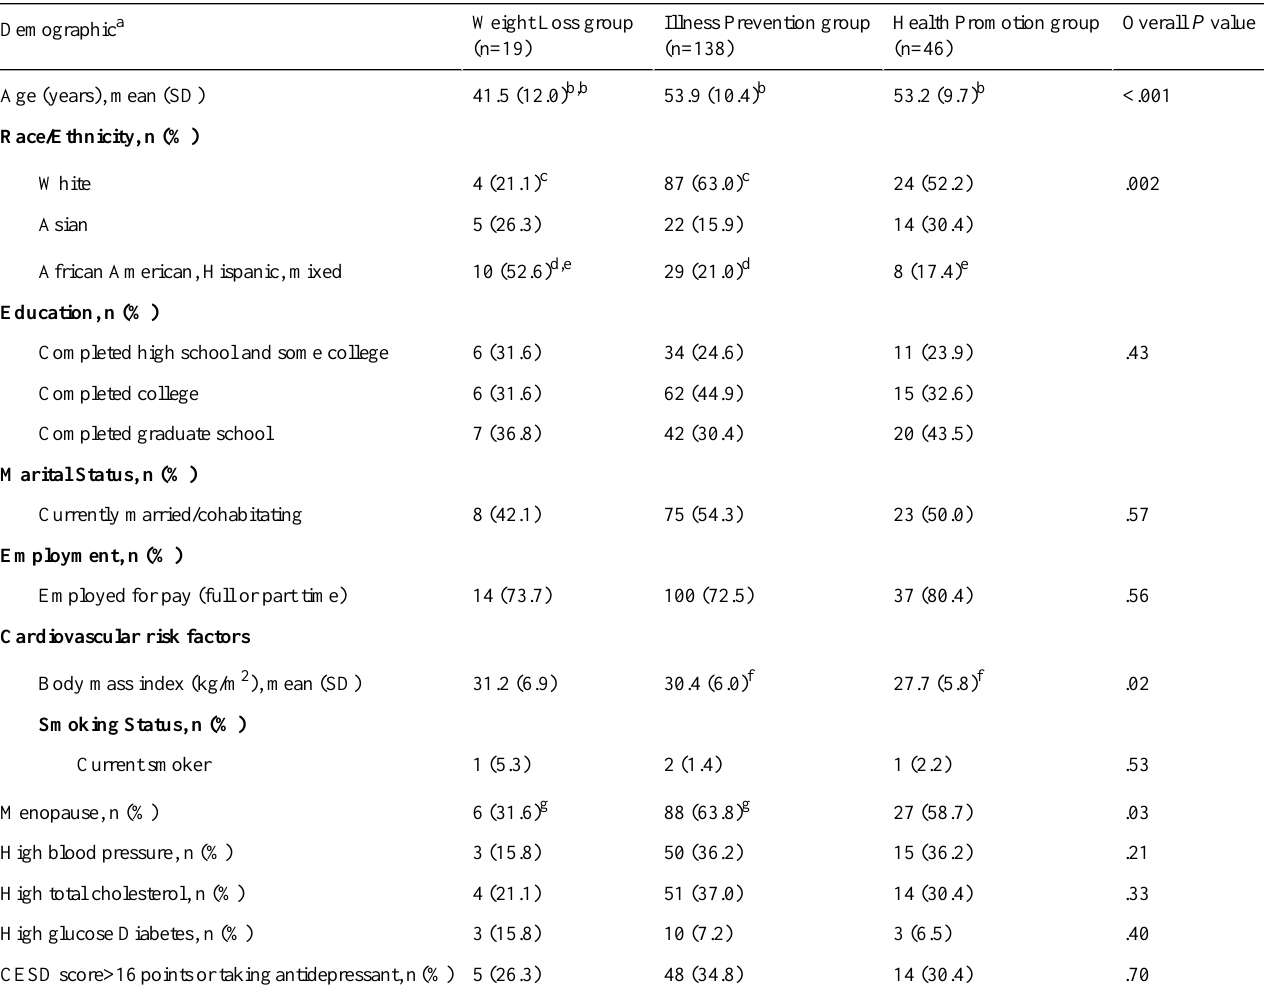
Table 2. Baseline characteristics of participants by 3 cluster groups. The presence of two footnotes indicate a pairwise